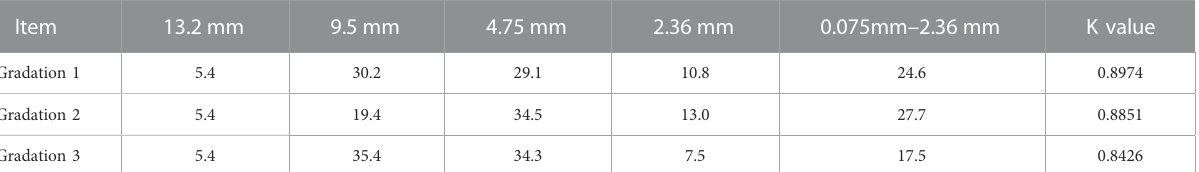
TABLE 14 Proportion and K value of the aggregates.